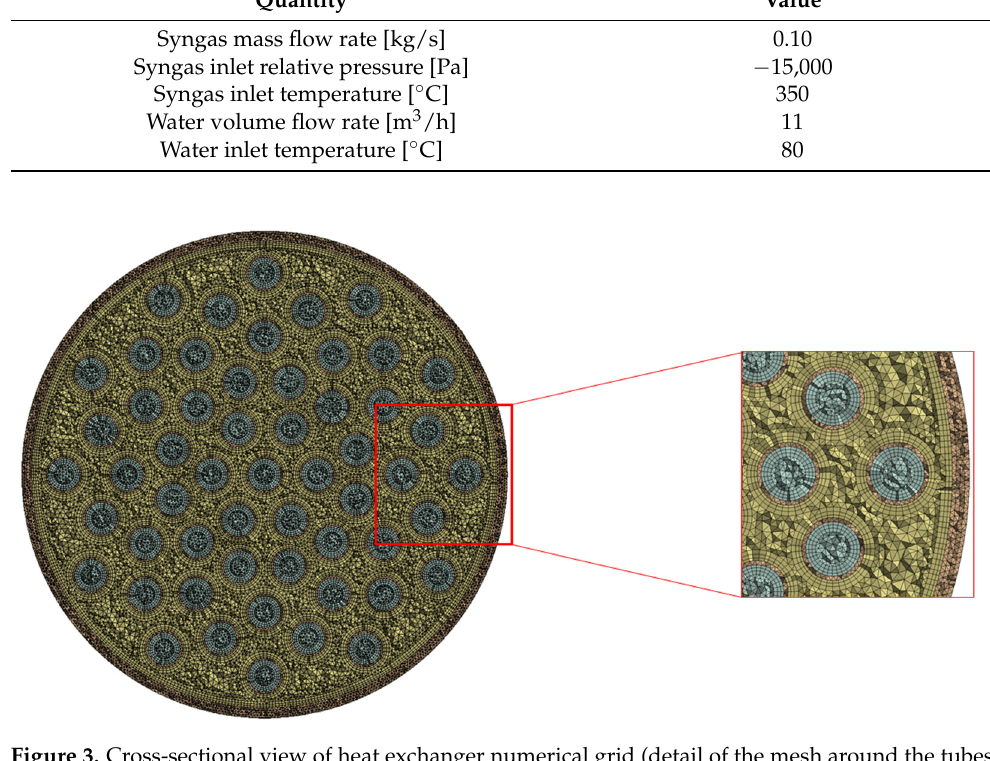
Figure 3. Cross-sectional view of heat exchanger numerical grid (detail of the mesh around the tubes shown in a close-up).